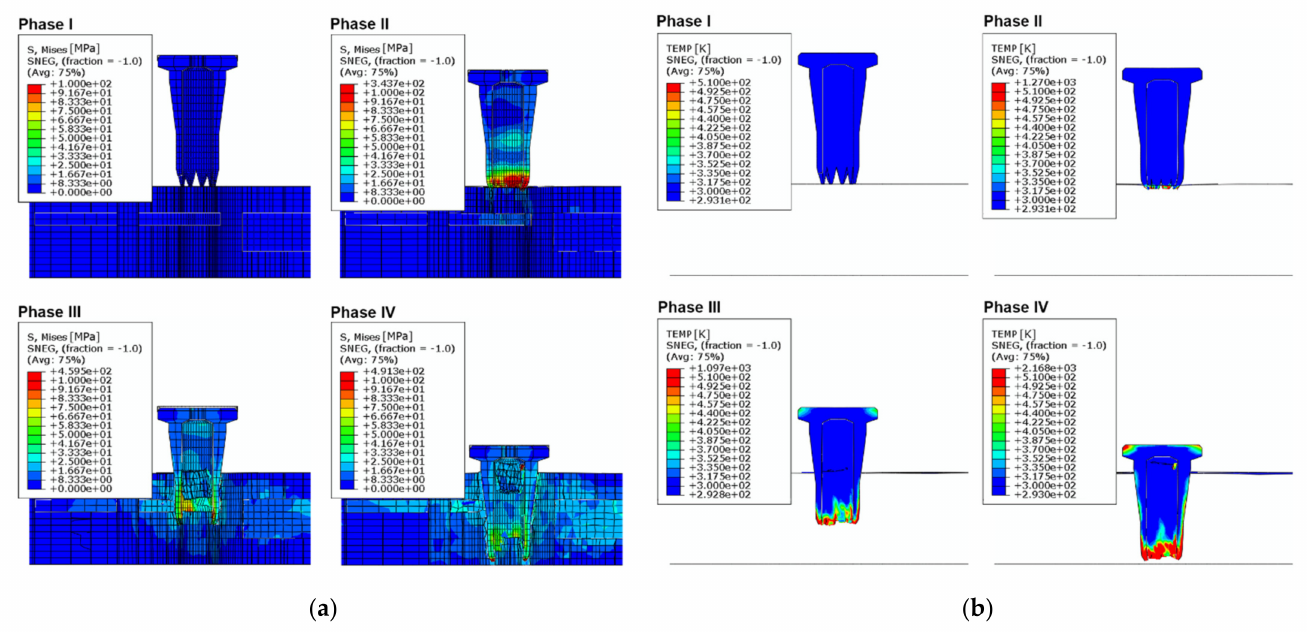
Figure 7. Simulation of the MM-Welding ® LiteWWeight ® process: ( a ) stress distribution within the four process phases; ( b ) Temperature distribution within the four process